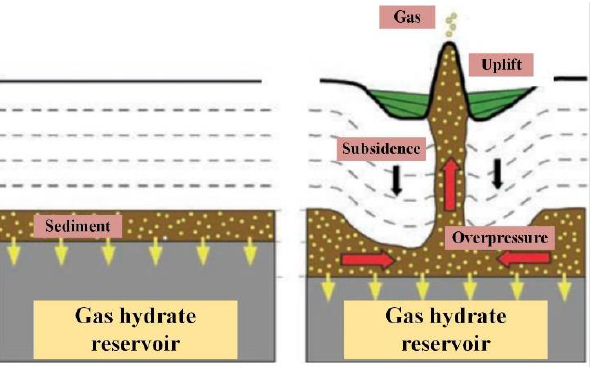
Figure 2. Relationship between gas hydrate decomposition and seafloor terrain subsidence [21].